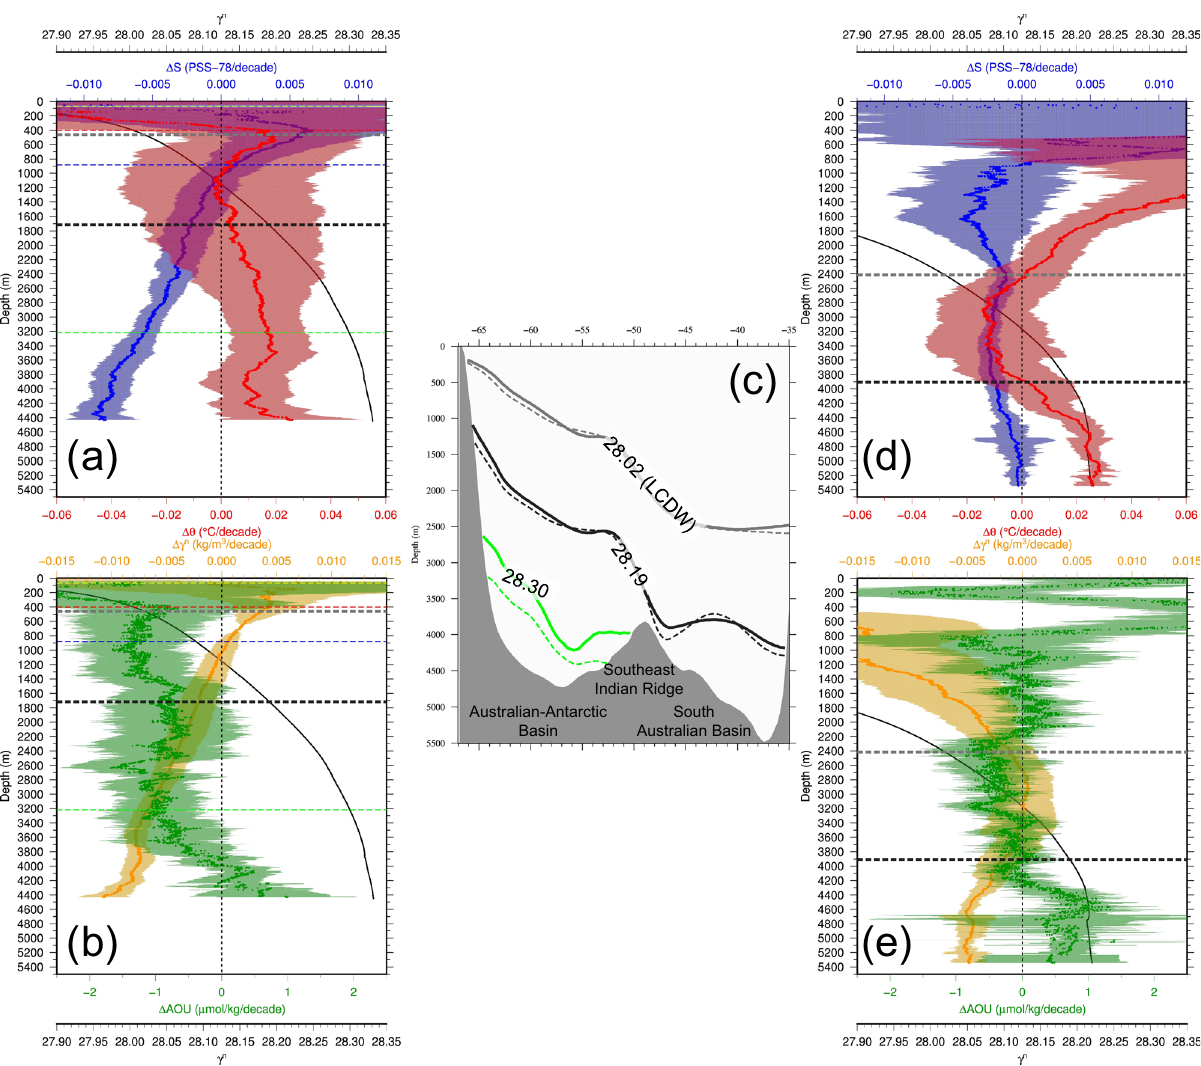
Fig. 5 Multi-decadal trends in the core region in the Australian-Antarctic Basin (core AAB) and South Australian Basin (SAB) with climatological isopycnals and bottom topography along 124° E. a , b are water mass change component of multi-decadal trends in the core AAB with a showing those of potential temperature and salinity and b showing those of apparent oxygen utilisation (AOU) and neutral density. c Labelled grey, black, and green lines indicate the isopycnals along 124°E (corresponds to middle longitude in the Australian-Antarctic Discordance) for γ n = 28.02, 28.19, and 28.30kg m − 3 , as determined by data obtained at WOCE/GO-SHIP sections SR3, I09s, and I08s, with a previously proposed interpolation scheme 32 . Solid lines re fl ect the 1994 – 1995 condition and broken lines re fl ect 2019 condition. d , e are observed multi-decadal trends in the SAB with d showing those of potential temperature and salinity and e showing those of AOU and neutral density. Shaded areas and black solid lines in a , b , d and e indicate 95% con fi dence interval and mean (spatio-temporal) neutral density, respectively. Grey and black broken lines in a , b , d and e indicate isopycnals for γ n = 28.02 and 28.19 kg m − 3 , respectively. The dashed yellow, red, blue, and green lines in a , b , d and e are de fi ned in Fig.